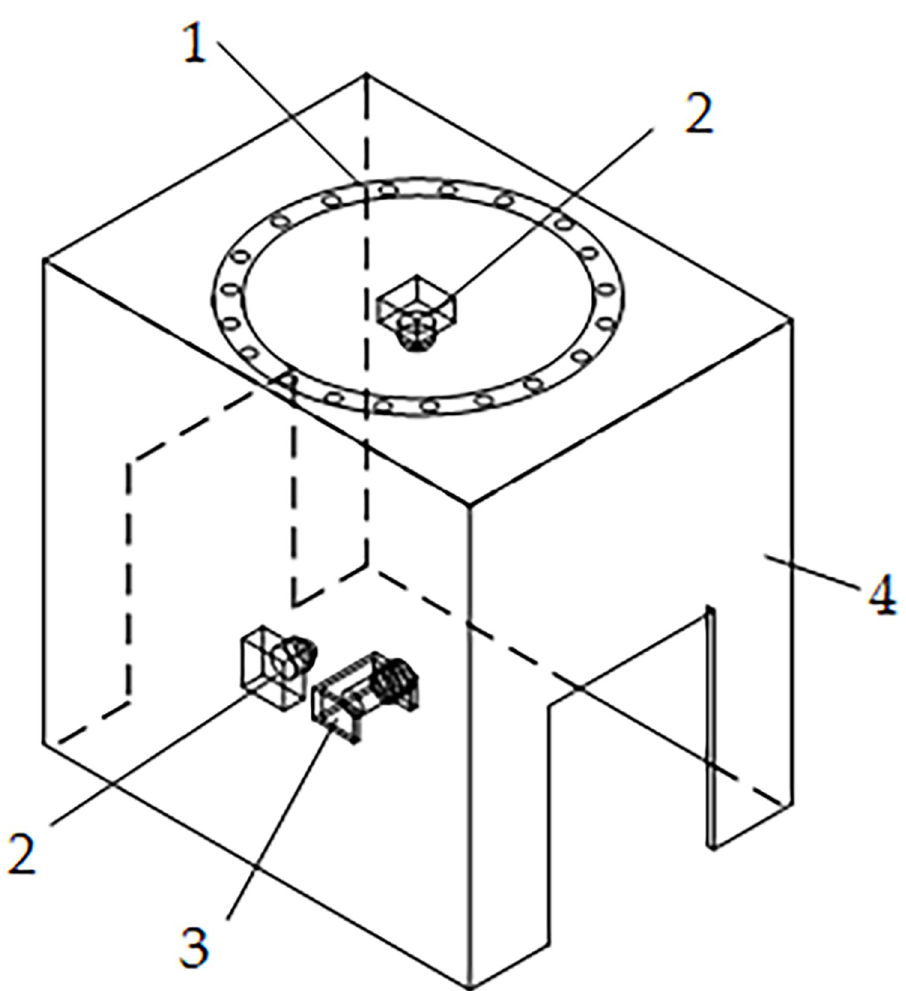
Fig 2. Sketch of the structure of the vision-based detection device. 1-ring light source 2-camera 3-photoelectric switch 4-dark box housing.